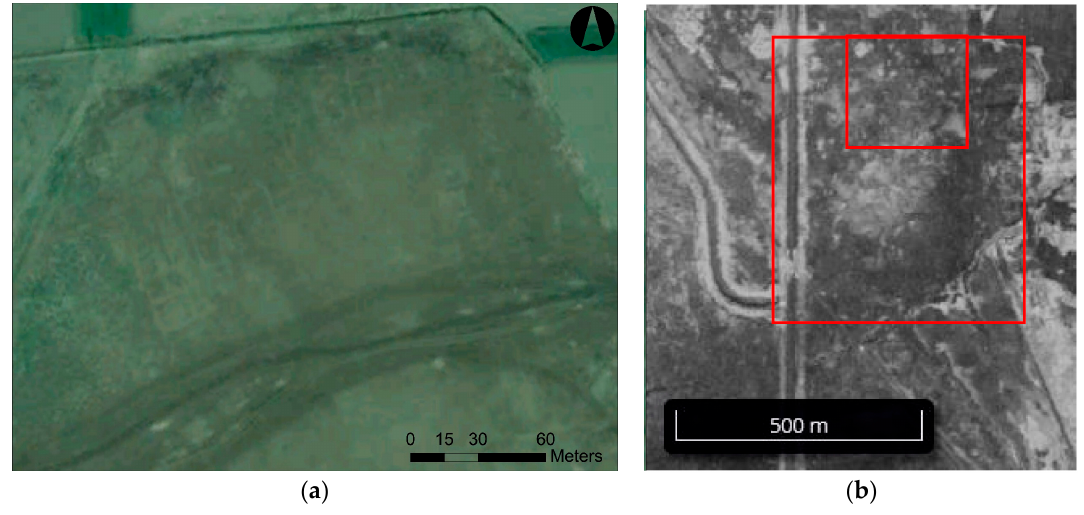
Figure 25. ( a ) The site of Umm Gafar Image courtesy Google Earth; ( b ) 1968 CORONA image. The original boundaries of the site are within the larger red box, while the area in image ( a ) is in the smaller box. Image courtesy of the Center for Advanced Spatial Technologies, University of Arkansas/U.S. Geological Survey.